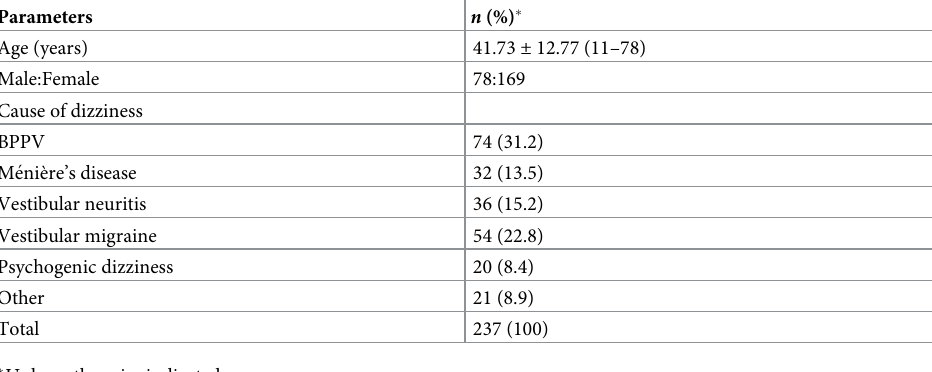
Table 1. Demographic characteristics of the patients. Parameters